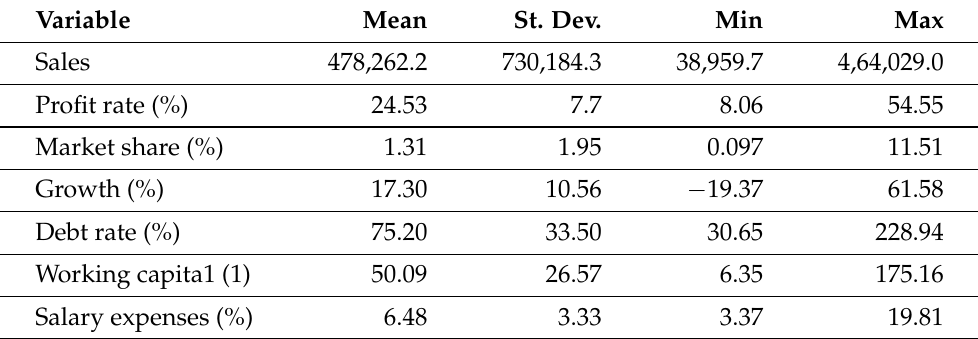
Table 1. Descriptive statistics of the selected companies (1000 Norwegian